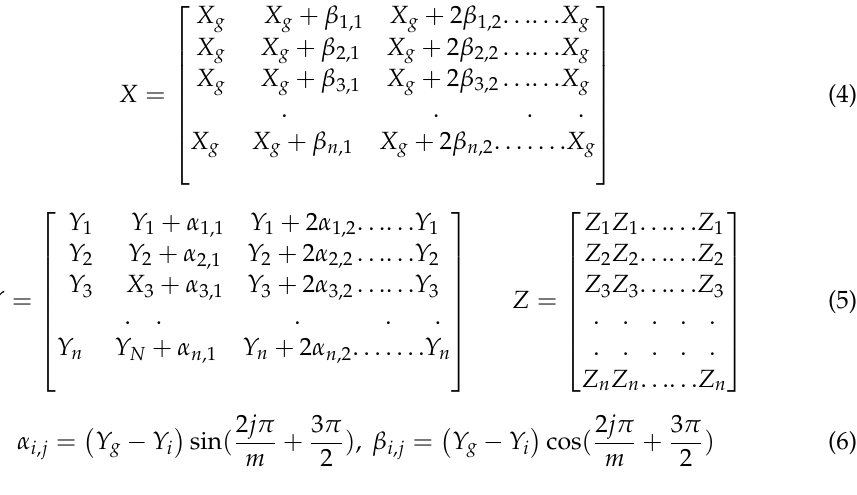
Figure 6. ( a ) Automatically generated 3D tower model; ( b ) superimposition of the tower point cloud onto the tower model.